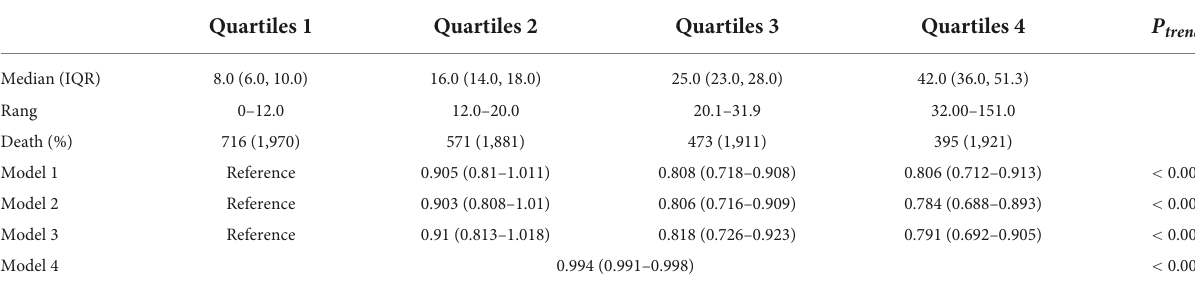
TABLE 3 Cardiovascular disease mortality according to quartiles of serum lycopene concentrations among patients with CKD. Quartiles of serum lycopene level ( µ